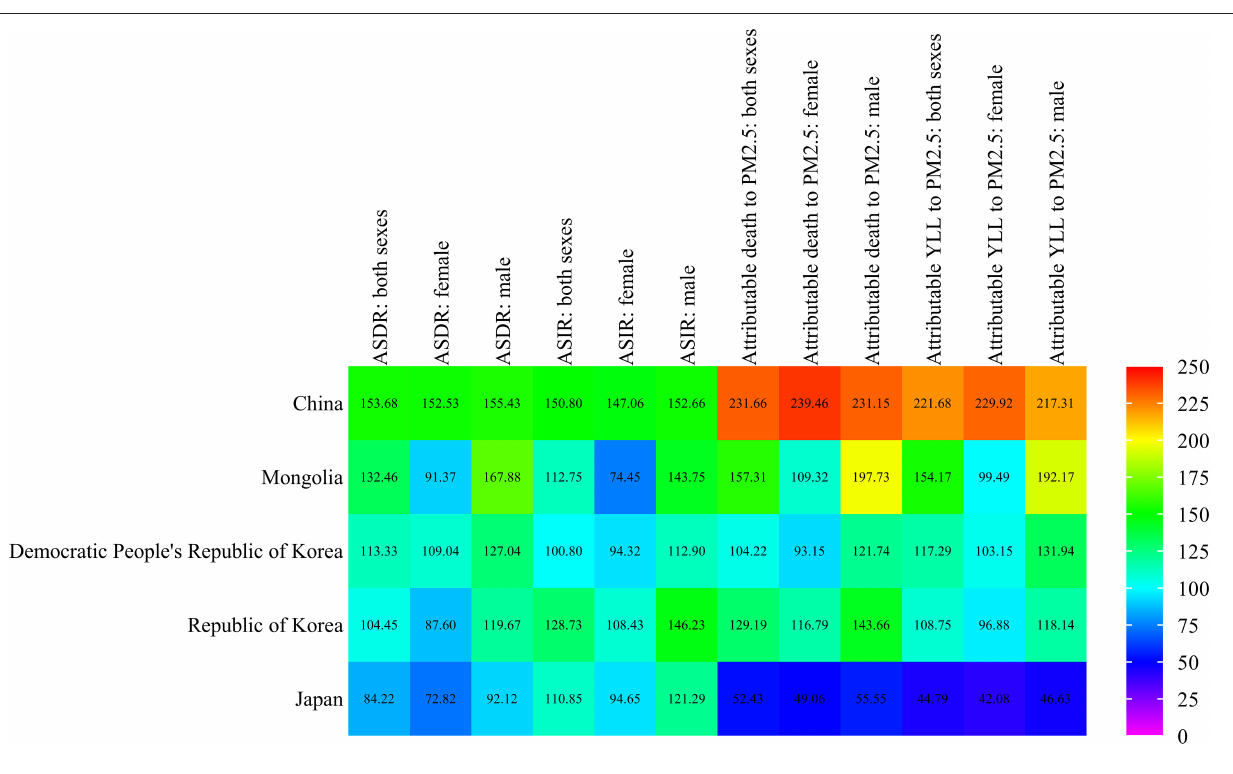
FIGURE 4 | Age-standardized rates of lung cancer attributable death and YLL to PM 2.5 in East Asia compared with those globally in